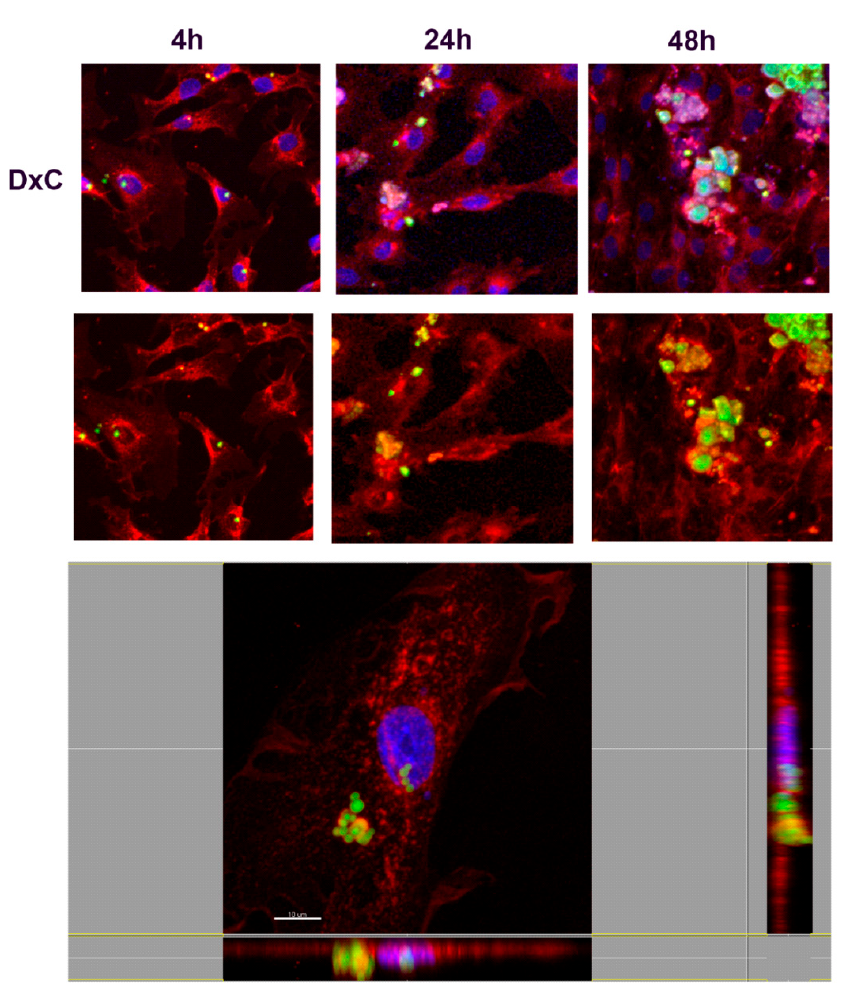
Figure 10. Confocal laser scanning microscopy images of carboxylate dextran (DxC) NMP cellular uptake. (TOP panel) The cells were stained with wheat germ agglutinin conjugated to Texas Red (red) and counterstained with Hoescht 33258 to visualize the nucleus (blue). Scale bars, 30 µ m. (BOTTOM panel) Confocal X-Y, X-Z, and Y-Z sections in max intensity projection mode (MIP modality). Side panels present z -sections along the x and y planes and show the 3D distribution of cells, confirming that DXC-NMPs were present on the cell, attached on the outside of the membrane after 4 h incubation. Scale Bar, 10 μ m.